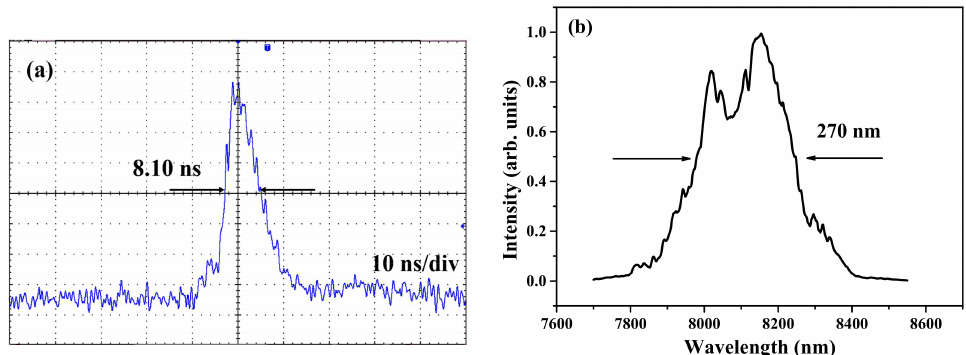
Figure 6. ( a ) Pulse width, ( b ) ZGP OPO